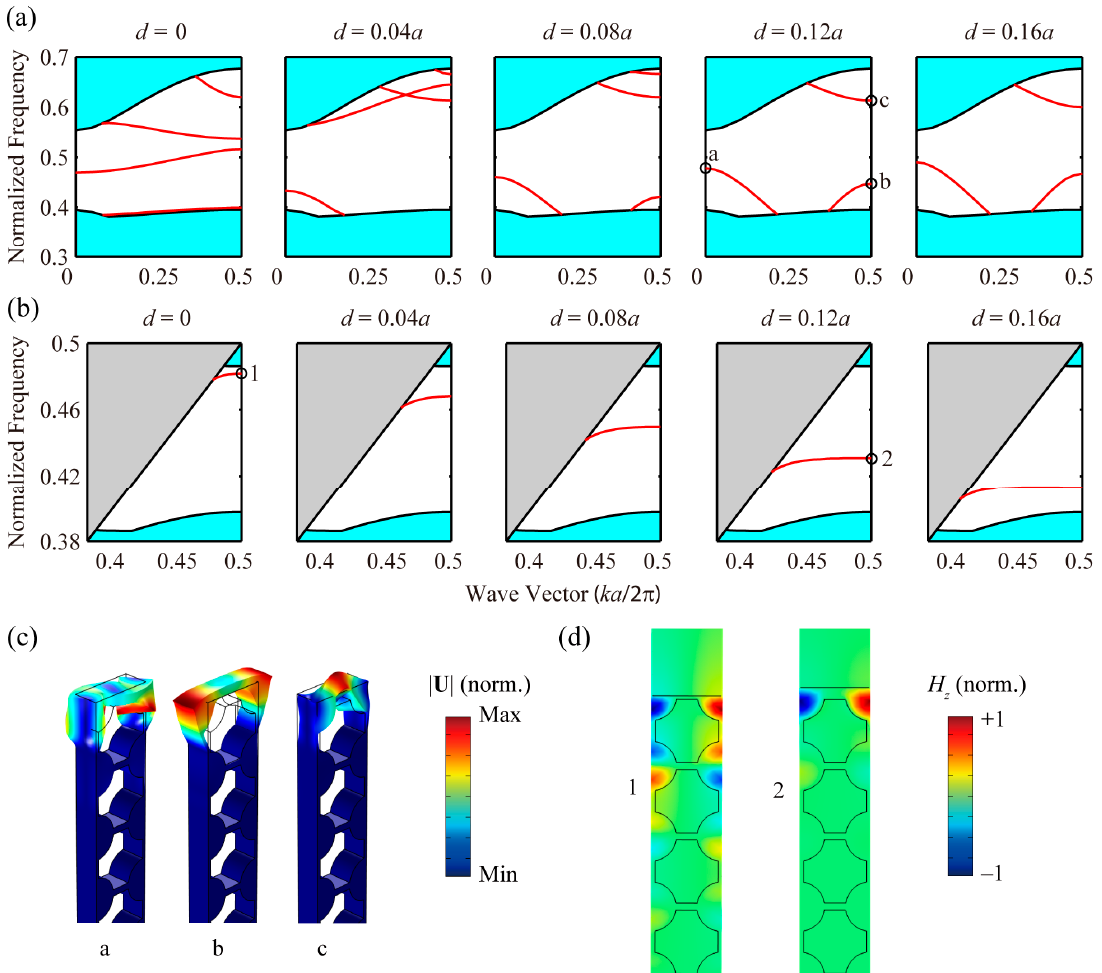
Figure 4. Dispersion curves of the surface wave bands of phononic ( a ) and photonic even ( b ) modes for different d , where d increases from 0 to 0.16 a with a step of 0.04 a . The cyan and gray areas represent the projected bulk modes and light cone, respectively. ( c ) Displacement field distributions and deformed patterns corresponding to different phononic surface bands. ( d ) Magnetic field ( H Z ) distributions at plane z = 0 corresponding to different photonic surface bands.